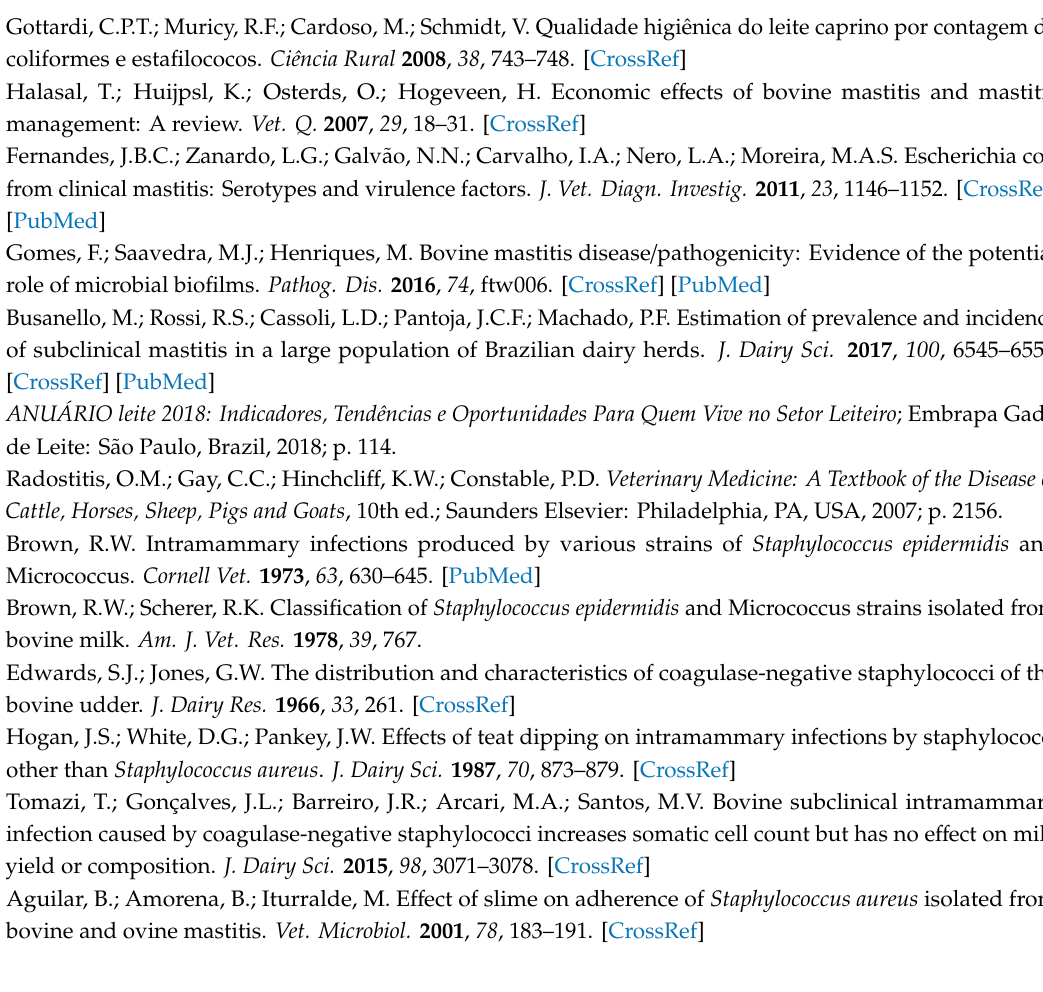
Table S1: Brazilian state of origin (Minas Gerais − MG; Pernambuco − PE; Paran á − PR; Rio Grande do Sul − RS; Santa Catarina − SC), identification number of the farm, geographic coordinates, number of the isolate, cluster, and sequence type